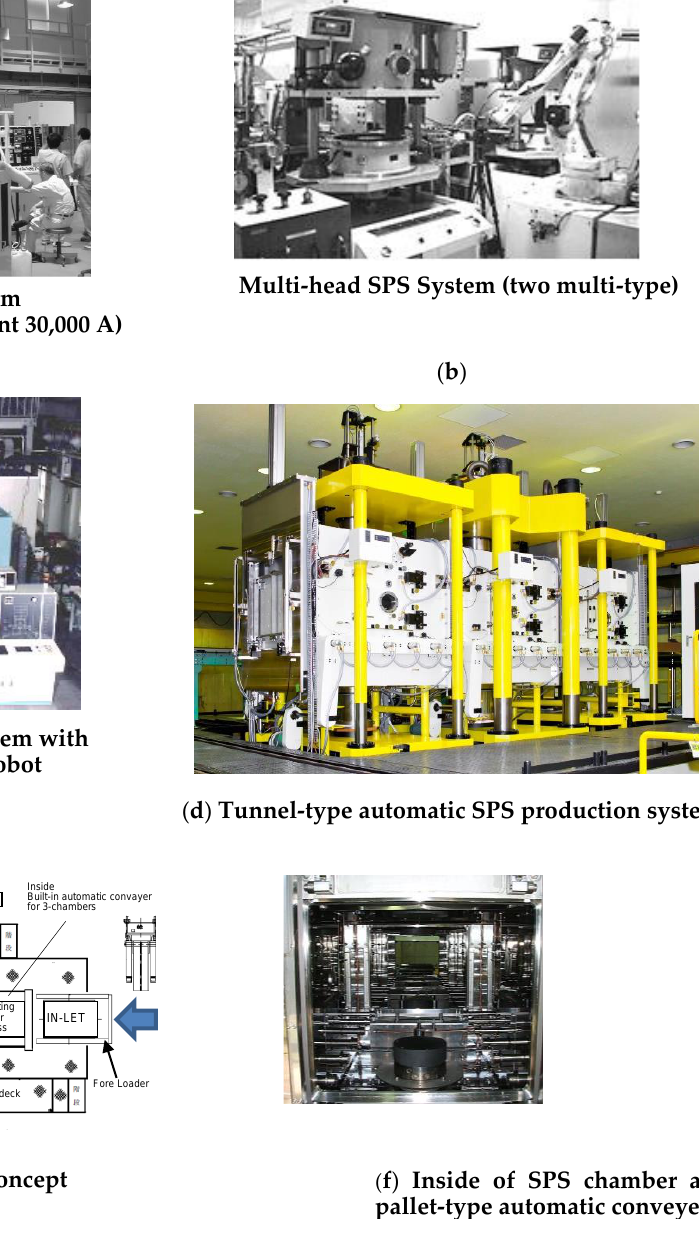
Figure 17. Typical examples of automated production type SPS systems: ( a ) Batch-type large-size SPS System (max. pressure 3 MN/pulse current 30,000 A); ( b ) Multi-head SPS System (two multi-type); ( c ) Batch-type SPS production System with automatic materials handling robot; ( d ) Overview of the world’s largest semi-tunnel-type automatic SPS production